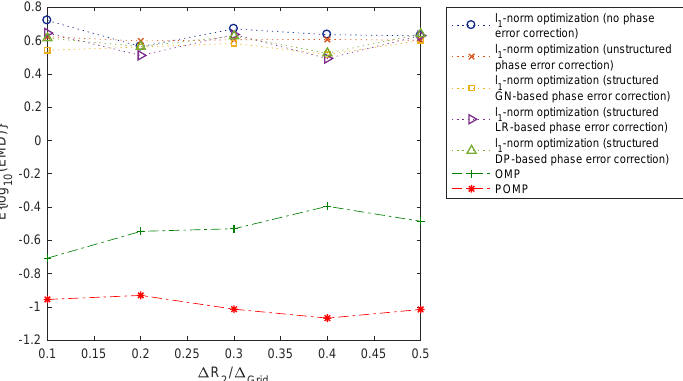
Figure 8. EMD performance of the OMP, POMP, and l 1 -norm regularised optimisation methods versus various levels of phase error (SNR = 10 dB).